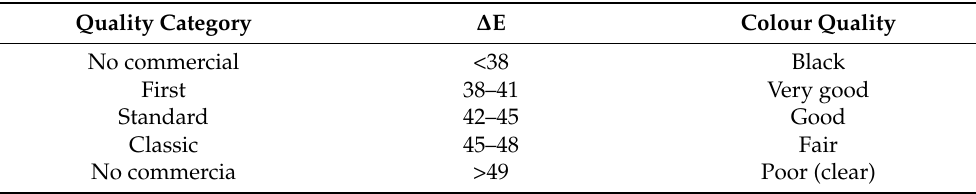
Table 5. Commercial categories based on chromatic classification in ME ornamental